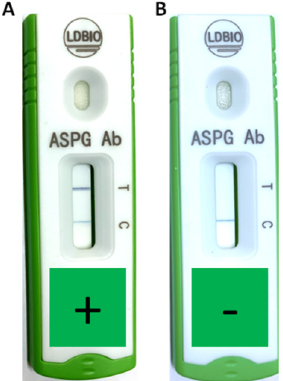
Figure 1. Positive ( A ) and negative ( B ) LDBio Aspergillus immunochromatographic technology in CPA patients from Indonesia. Positive result was indicated by gray / black line under “T” marker. The gray / black line under “C” marker was used for assured the validity of the test. J. Fungi 2020 , 6 , x FOR PEER REVIEW Table 2. Laboratory results.